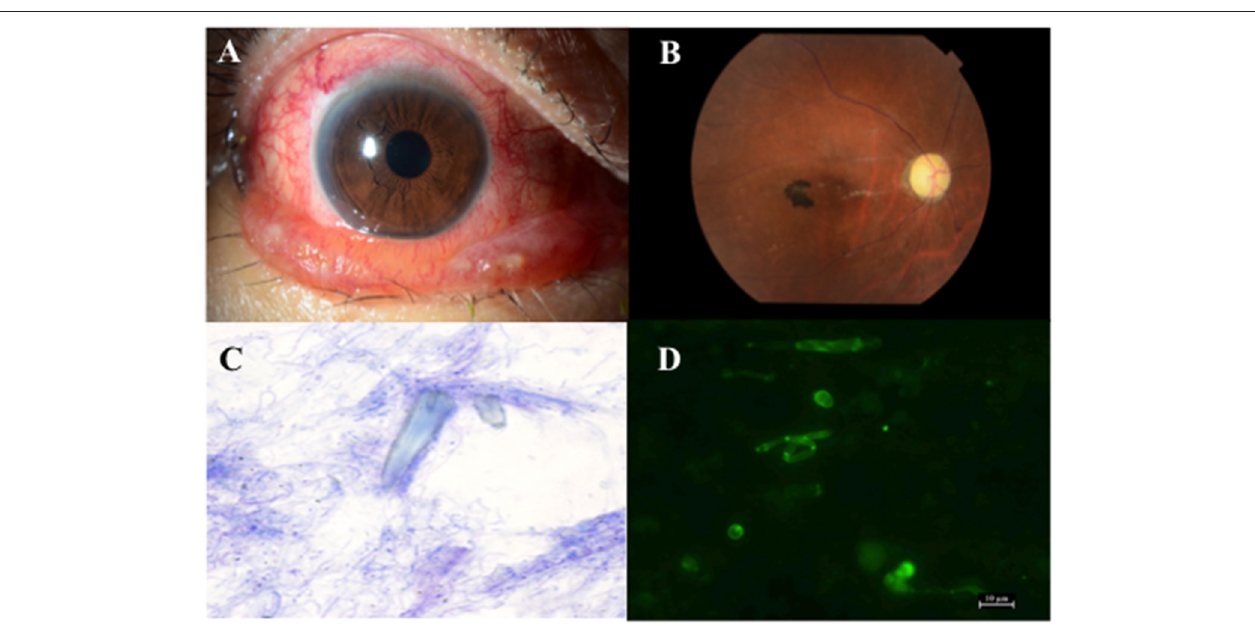
FIGURE 2 | (A) Anterior segments of the patient in case 2 show conjunctival hyperaemia and chemosis. (B) Fundus photograph of the patient in case 2 shows retinal artery occlusion and optic disc atrophy. (C) Microscopic picture of the lacrimal sac concretion after Diff-Quik staining ( × 1,000) shows bacteria around the amorphous crystal-like structure. (D) Microscopic picture of the lacrimal sac concretion after fungiflora Y staining shows yeast-like